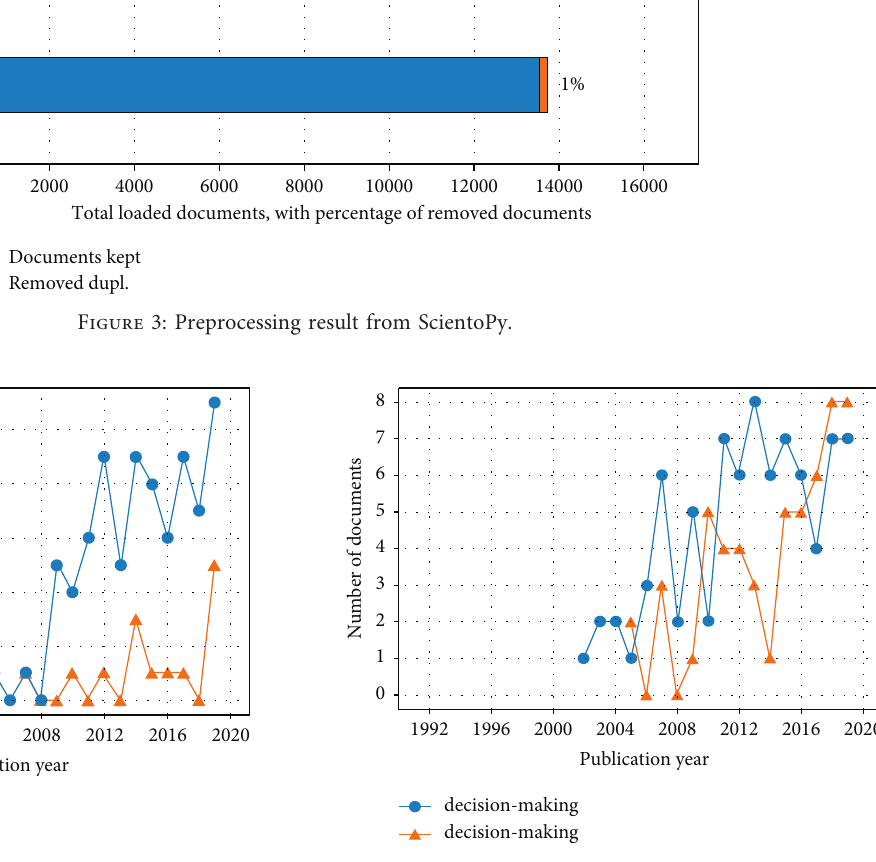
Figure 4: Timeline graph for publications with optimisation or optimization as keywords during the period 1991–2020.